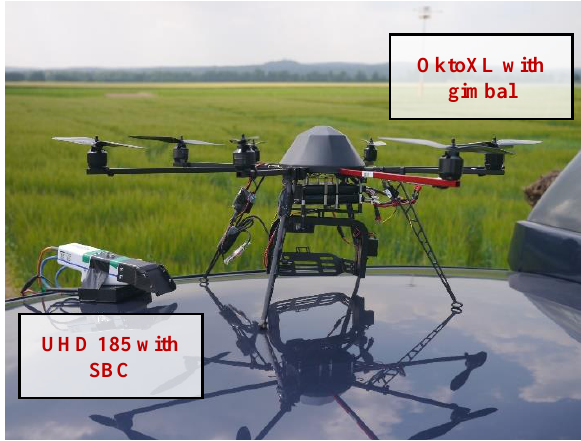
Figure 2: UHD 185 with SBC and OktoXL with